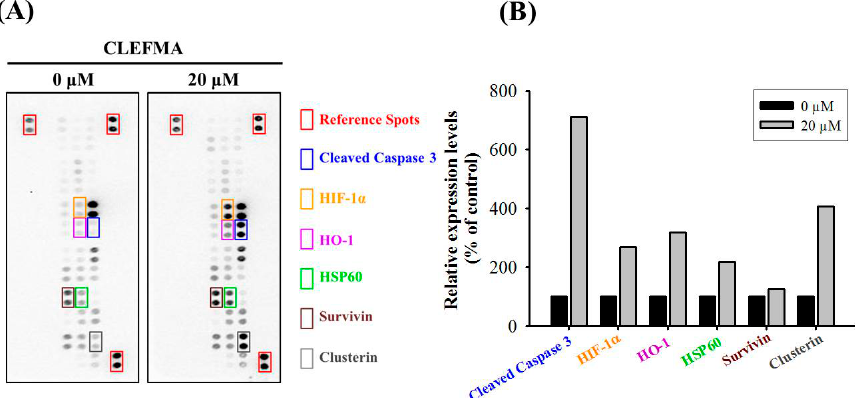
Figure 3. E ff ects of CLEFMA on the human apoptosis array in U2OS cells. ( A ) After treatment with 20 µ M CLEFMA for 24 h in U2OS cells, the human apoptosis array, with 35 apoptosis-related proteins included, was employed as described in the Materials and Methods. ( B ) The five increased proteins were subjected to quantitative